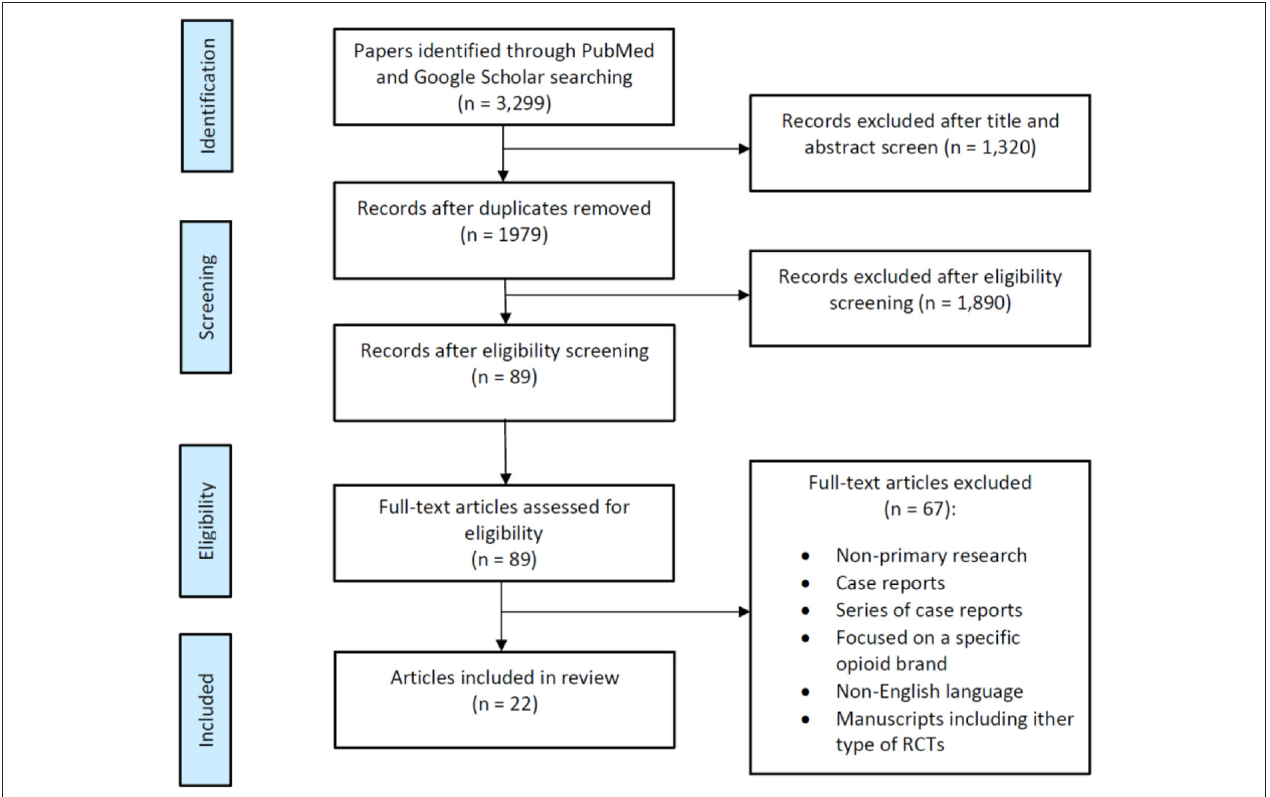
FIGURE 1 | Flow diagram summarizing the selection of randomized clinical trials (RCTs) describing postoperative nausea and vomiting (PONV) in female surgical population.